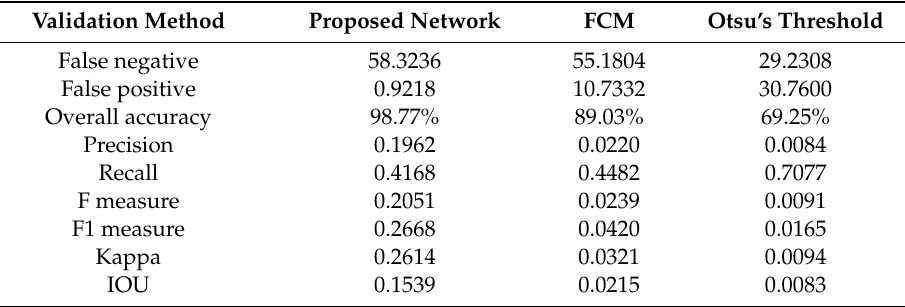
Table 6. Accuracy of the model applied to the Hanoi area.